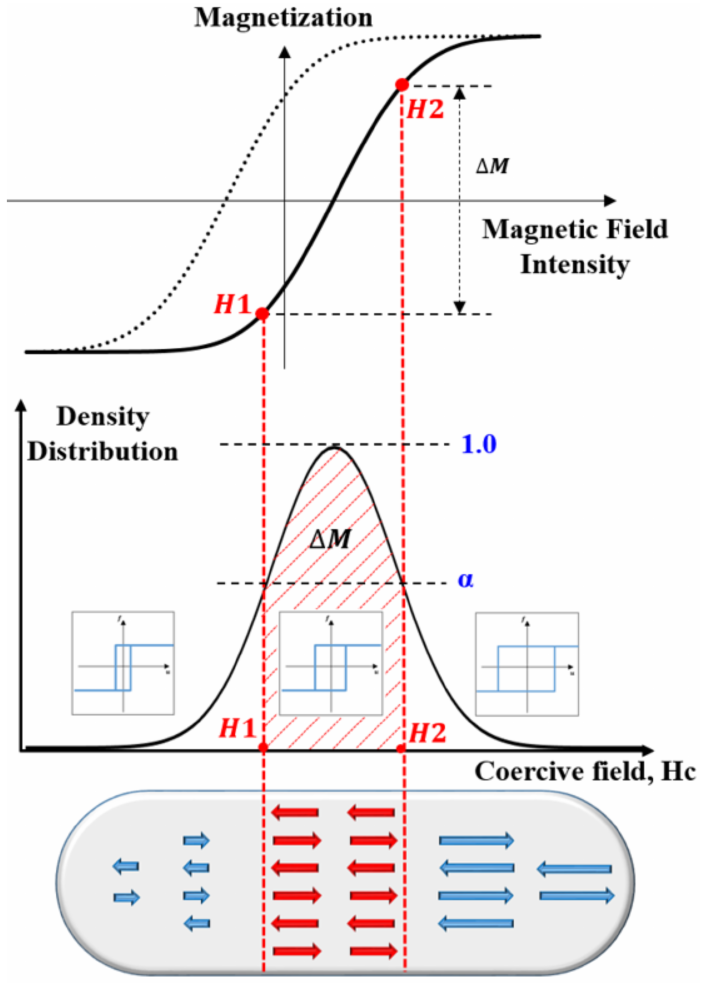
Figure 9. Process to establish the proposed